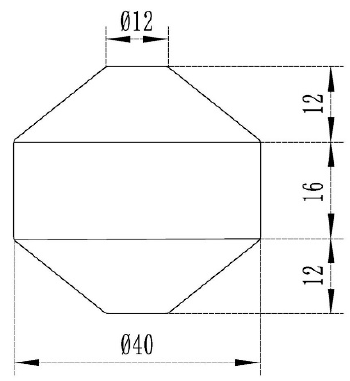
Figure 1. Dimensions of double cone specimens in millimeters.